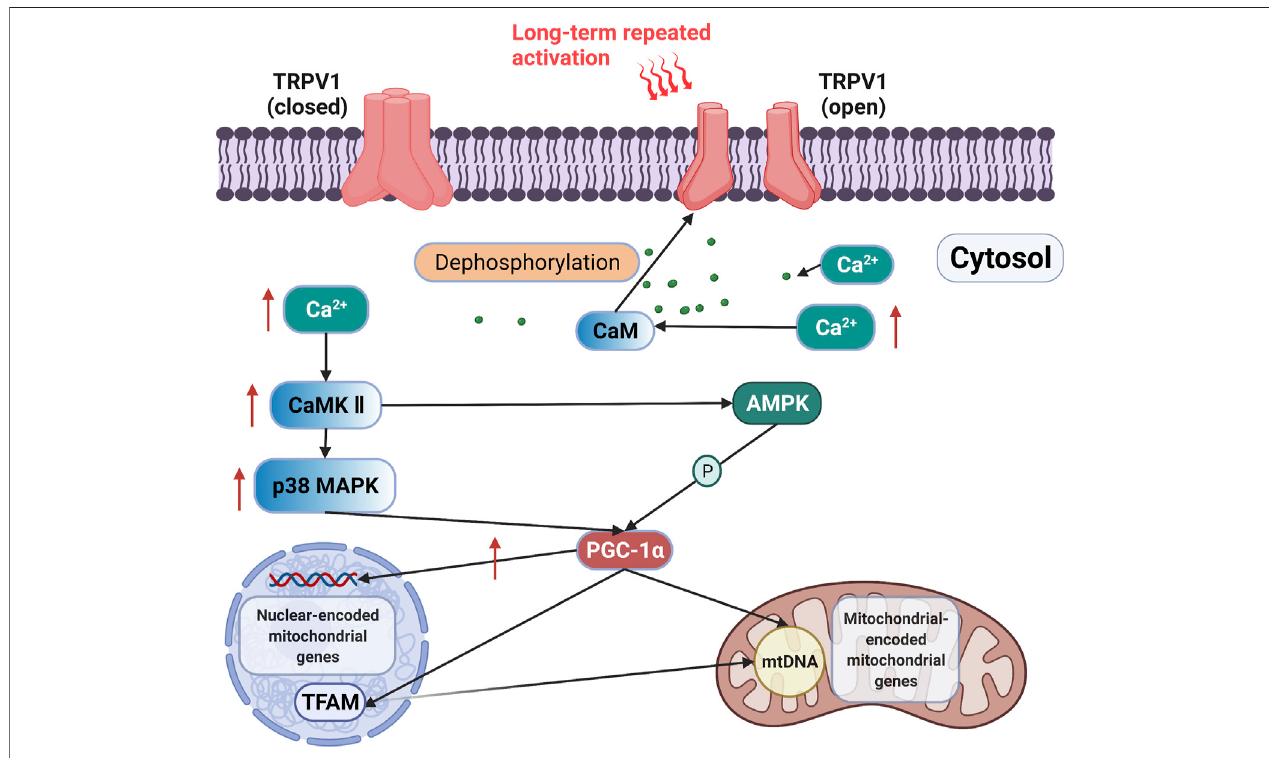
FIGURE1 | Signaling axis of TRPV1 isactivated to improve mitochondrial biogenesis. Long-term activation ofTRPV1 releases Ca 2+ from the SRto the cytoplasm, and the increase in Ca 2+ may induce PGC-1 α expression through the activation of CaMKII. The activation of PGC-1 α increases the expression of nuclear-encoded mitochondrial genes and upregulates mitochondrial DNA transcription and replication via TFAM (Islam et al., 2018).